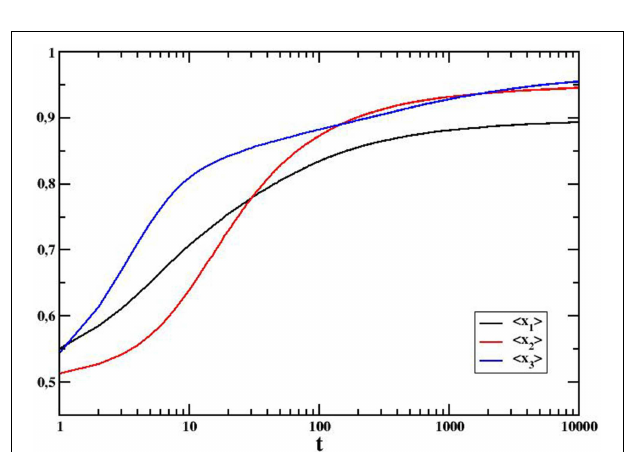
FIGURE 1 | Average opinion as a function of time for a system of N = 100 on a totally connected graph for three different initial conditions. Figure presents values averaged over 2000 independent realizations.